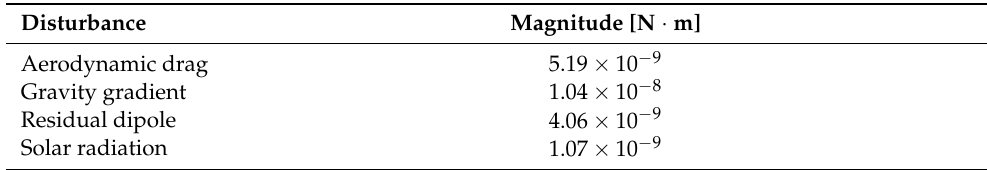
Table 3. Worst-case disturbance torque magnitudes.